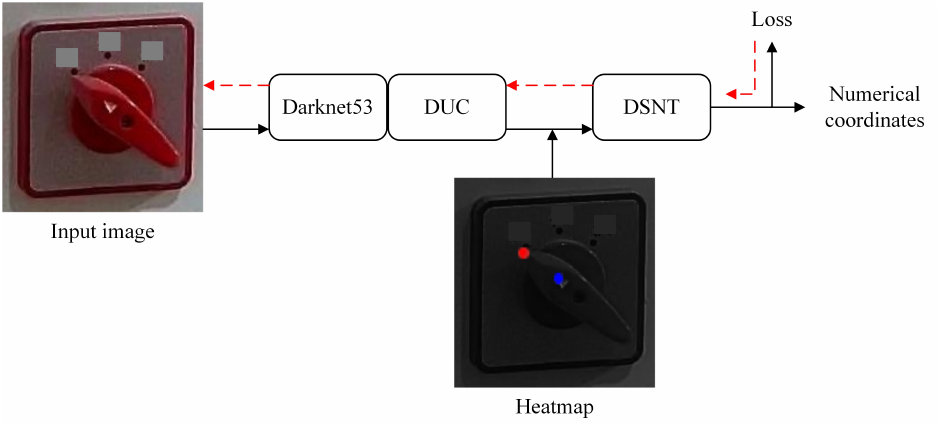
Figure 8. DSNT structure.